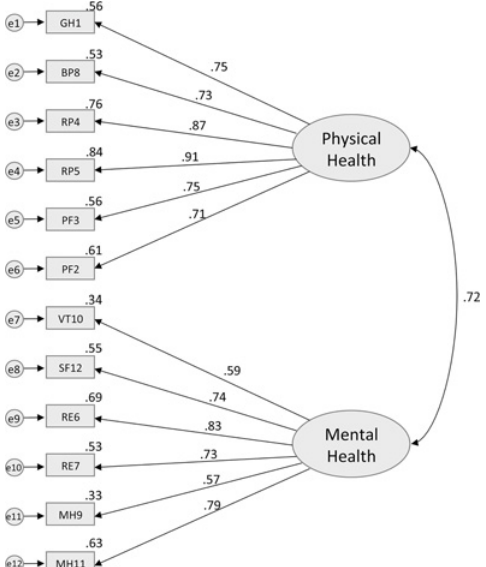
Fig 2. Standardized solution of the confirmatory factor analysis for the Model 2. GH1 — General Health: rating of general health; PF2 — Physical Functioning: moderate activities; PF3 — Physical Functioning: climbing several flights of stairs; RP4 — Role Functioning (Physical): accomplished less; RP5 — Role Functioning (Physical): limited in the kind work or other activities; RE6 — Role Functioning (Emotional): accomplished less (emotional problems); RE7 — Role Functioning (Emotional): less carefully than usual; BP8 — Bodily Pain: pain interference; MH9 — Mental Health: calm and peaceful; VT10 — Vitality: energy; MH11 — Mental Health: downhearted and depressed; SF12 — Social Functioning: health/emotional problems interfered with